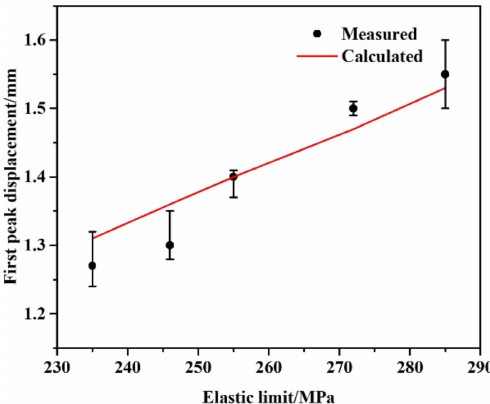
Figure 7. Comparison of calculated and measured results of first peak displacement.